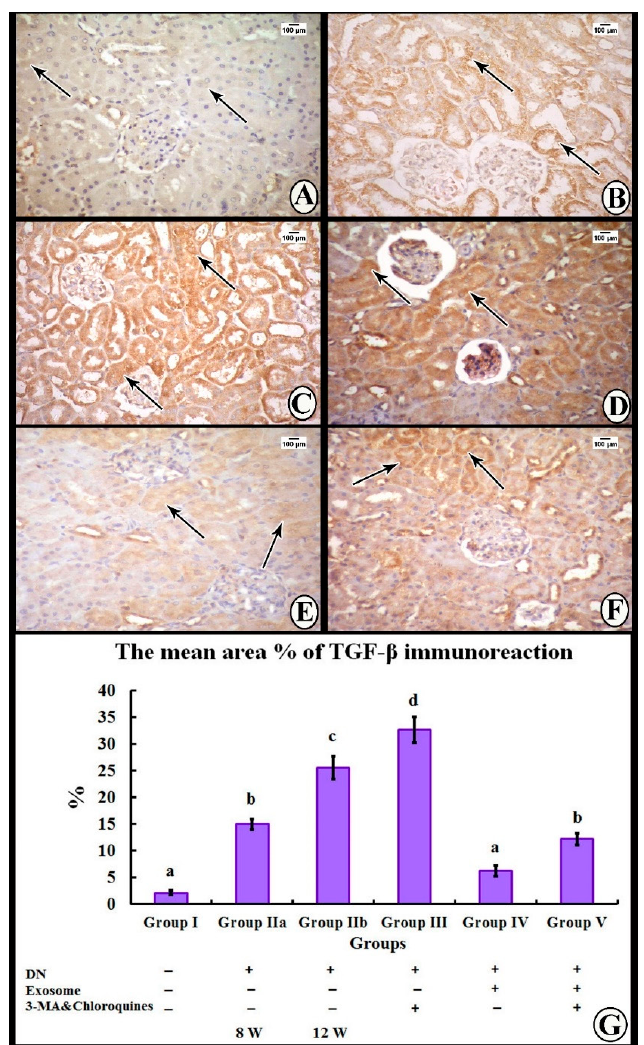
Figure 6. Immunohistochemical reaction for transforming growth factor β (TGF- β ) in sections of the renal cortex. ( A ) Group I shows mild positive cytoplasmic reaction in the tubular epithelial cells (thin arrows). ( B ) Group IIa shows tubular cells with a moderate positive cytoplasmic reaction (thin arrows). ( C ) Group IIb shows a strong positive reaction in the cytoplasm of the tubular cells (thin arrows). ( E ) Group IV shows a mild positive cytoplasmic reaction (thin arrows). ( F ) Group V